Question: In one sentence, what is this figure communicating?
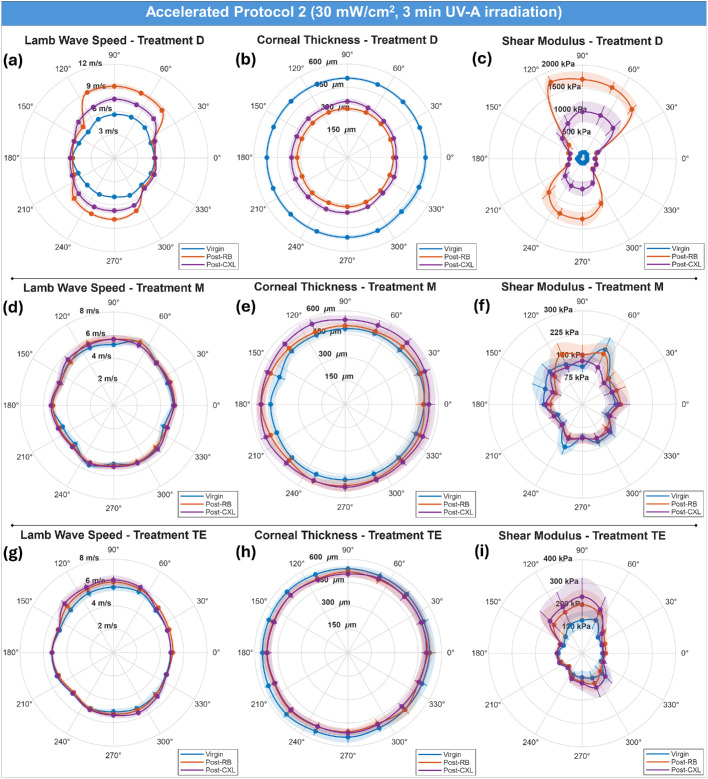
Answer: AP-2 multimeridian estimations. Group average meridian-dependent polar plots of Lamb wave speed ( left ), average corneal thickness ( center ), and estimated shear modulus ( right ) are shown in corneas in the Virgin, Post-RB, and Post-CXL phases when using photosensitizers D ( a, b, c ), M ( d, e, f ), and TE ( g, h, i ) and AP-2 (3 mW/cm 2 , 3 minutes of UVA). Scattered points shown mean values within a group. Standard errors (SD) for each meridian are shown in the plots as shadow patterns and bars.